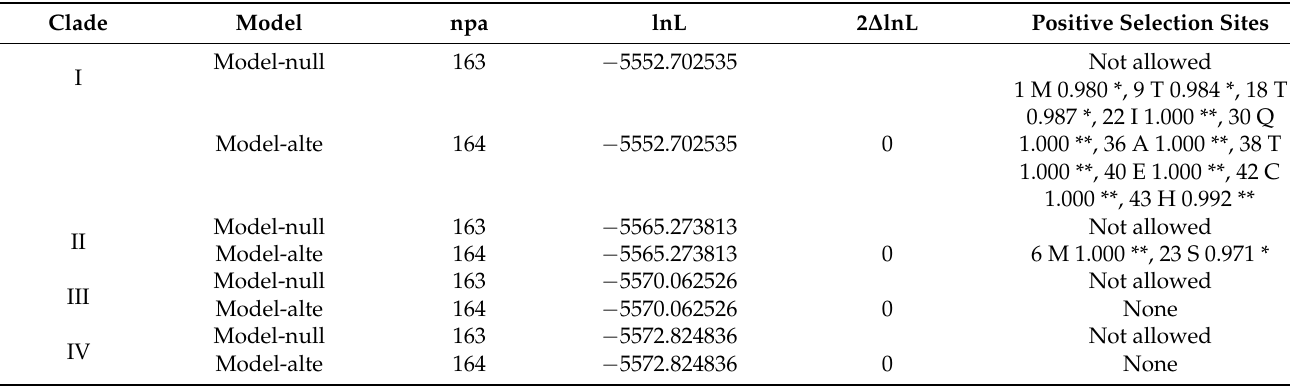
Table 1. Positive selection sites in each clade.